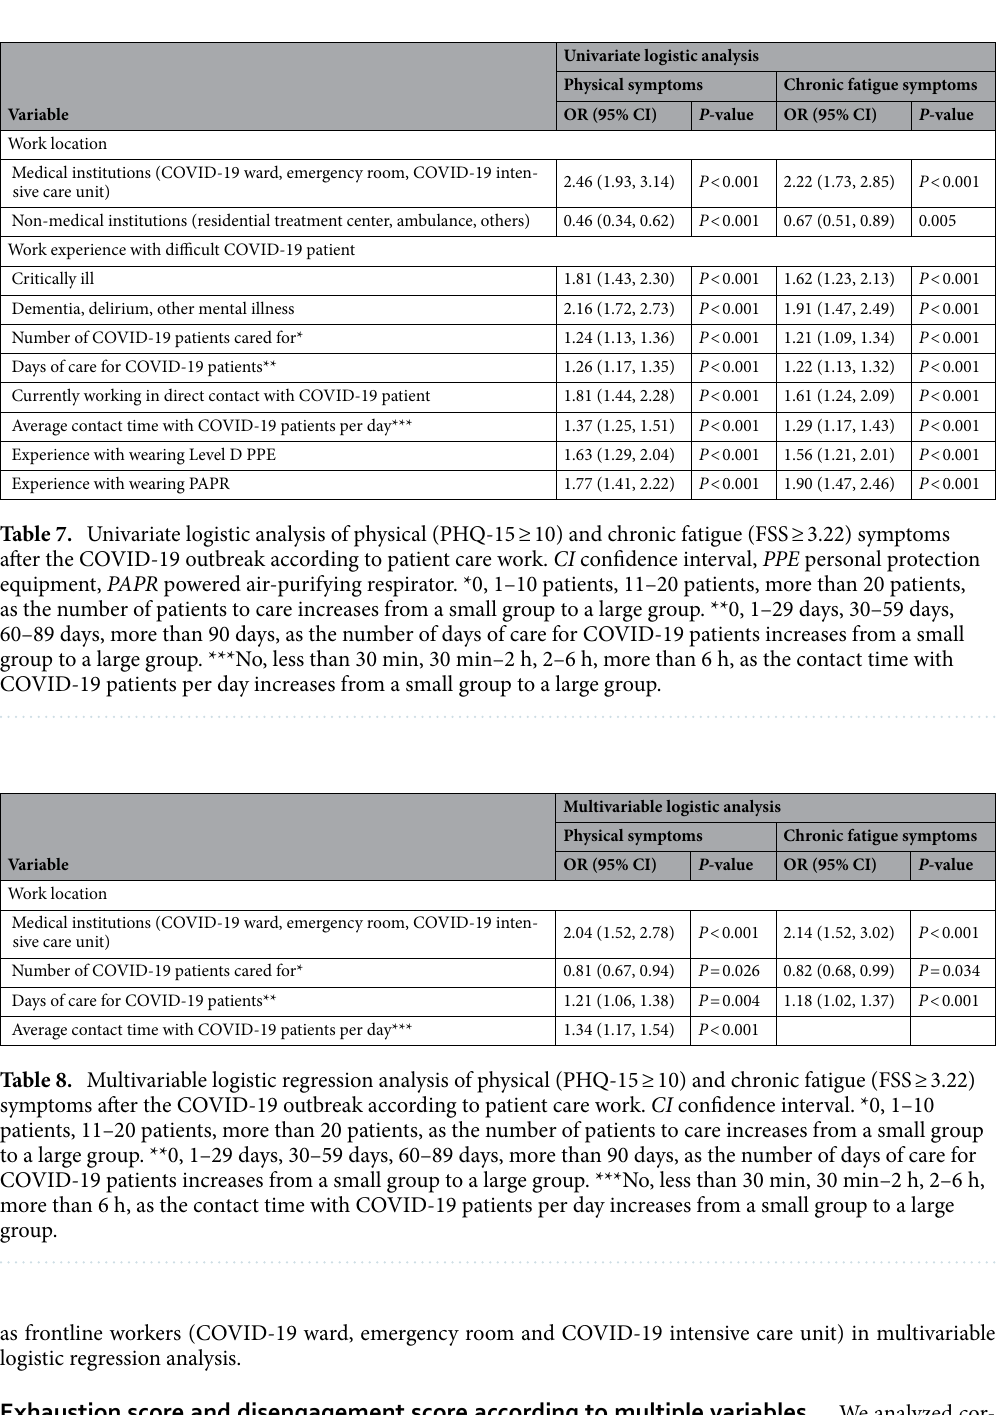
relation between scores for each of the two domains of burnout, exhaustion and disengagement, and clinical variables including demographic characteristics. Tables 9 and 10 show the strength of adjusted associations from linear regression analysis between the covariates and the score of each domains of burnout. The predictors explained 57.6% of exhaustion score and 46.9% of disengagement score. Chronic fatigue symptoms after the outbreak of COVID-19 had the strongest relationship with both exhaustion (standardized β = 1.96; p < 0.001) and disengagement score (standardized β = 1.89; p < 0.001). Consistent with the results in previous paragraphs, in addition to chronic fatigue symptoms after COVID-19, women, younger age, and GARS score were positively correlated with both exhaustion and disengagement score.